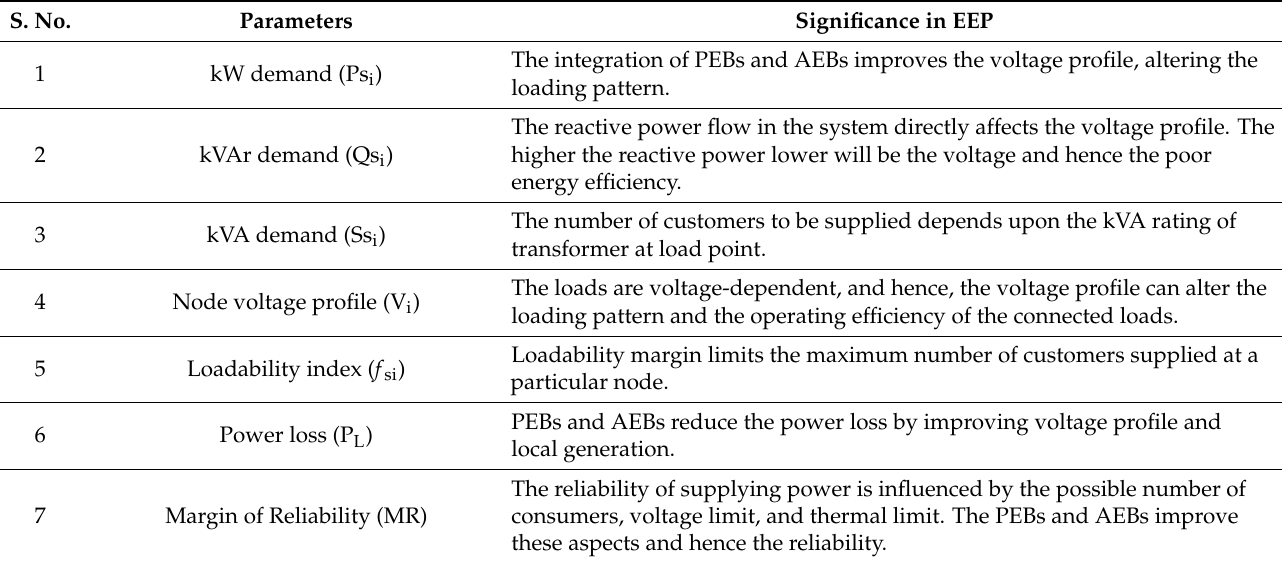
Table 1. Parameters for energy efficiency